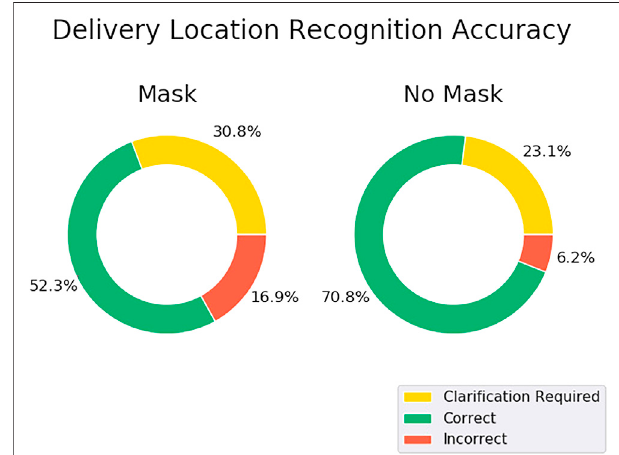
FIGURE 4 | First-pass outcomes of each recognition system with (left) and without (right) a face mask. Recognition was scored as correct when the intended target room was successfully recognized the fi rst try. Recognition was scored as clari fi cation required when the state machine needed to enter the error state and ask the user to repeat the instruction. Recognition was scored as incorrect when the system recognized the wrong room. This mode would require the user to reject the recognized room during the con fi rmation step and repeat the